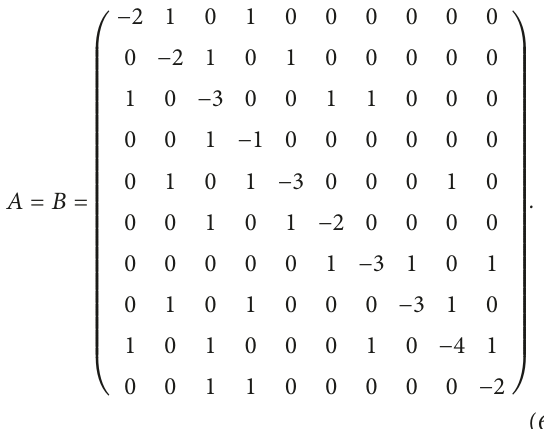
Figure 4: Time evolution of the error states e ( i � 1 , 2 , ... , 10 ) . (c) e i 3